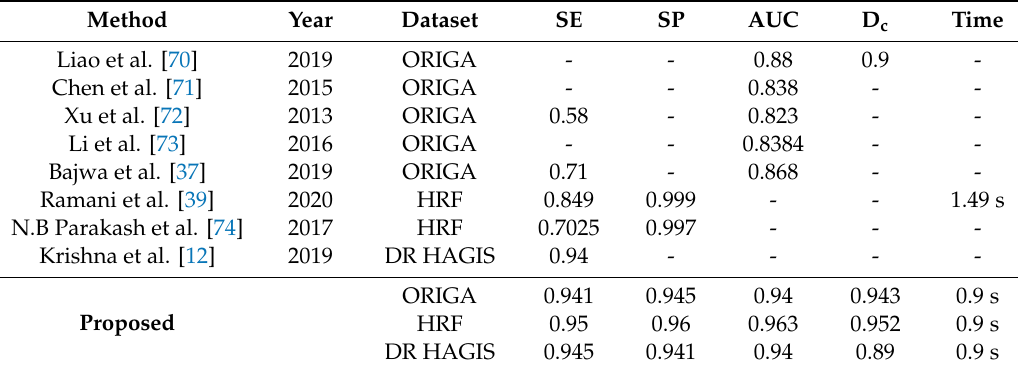
Table 9. Performance comparison of the Proposed Method with latest